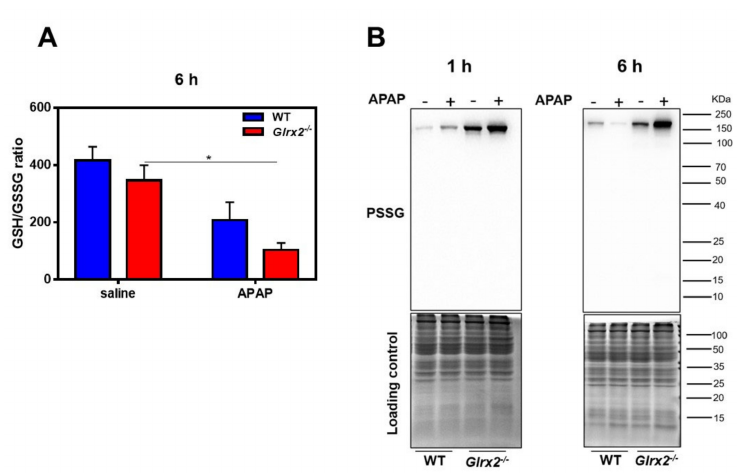
Figure 3. Glrx2 knockout exacerbated proteins glutathionylation level after APAP treatment. ( A ) The ratio of reduced GSH and oxidized GSSG detected using N -ethylmaleimide (NEM) to fix free thiols. Statistical difference among groups was analyzed using two-way ANOVA. Data are shown as mean ± SEM, n = 5, * p < 0.05. ( B ) The change of proteins glutathionylation 1 h and 6 h after APAP treatment, which was evaluated by Western blot after separation with non-reducing SDS-PAGE. Coomassie brilliant blue staining gels as the loading control. n = 4, a representative one is